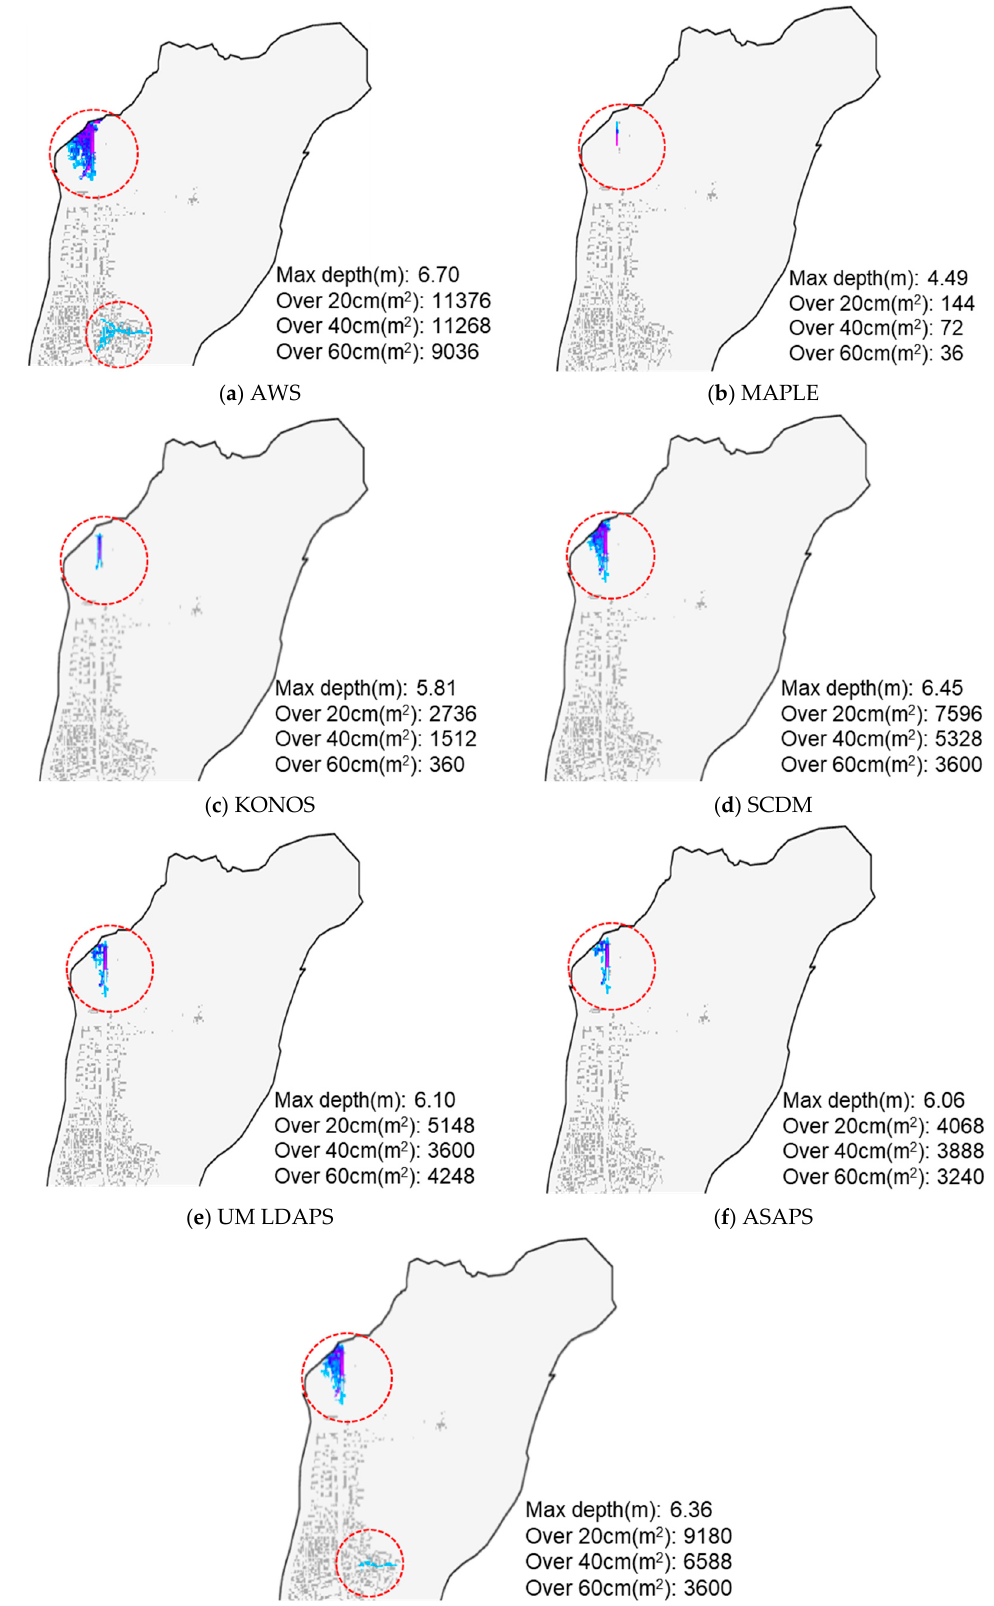
Figure 15. Maximum inundation maps produced using various QPFs and AWS data.